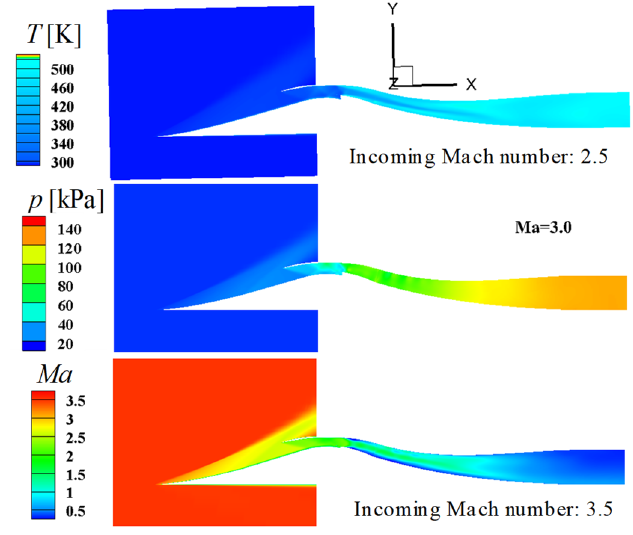
Figure 6. Flow field of the practical TBCC turbine inlet.